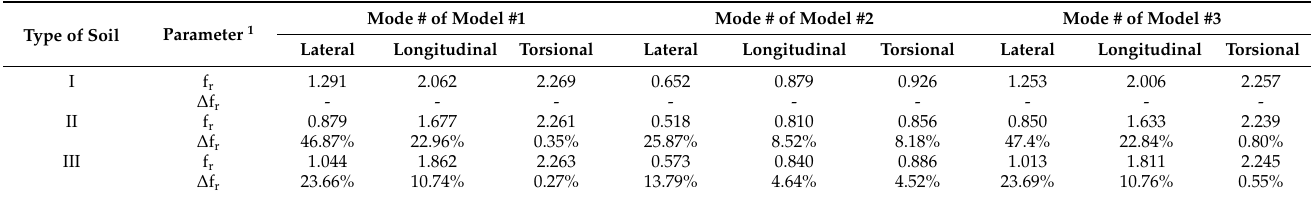
Table 7. Rocking frequency f r according to soil type.